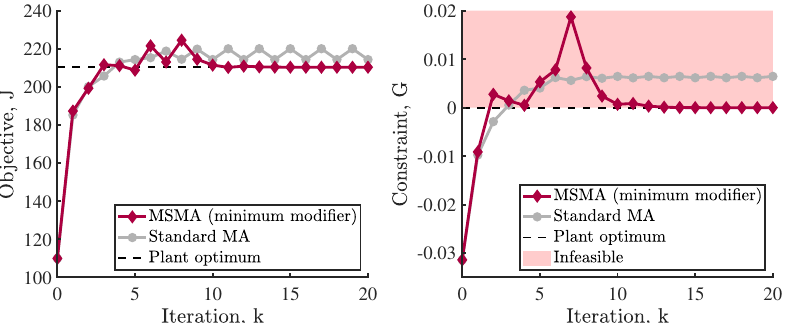
Figure 5. WO case study using the minimum modifier selection method, compared to standard MA using the same input